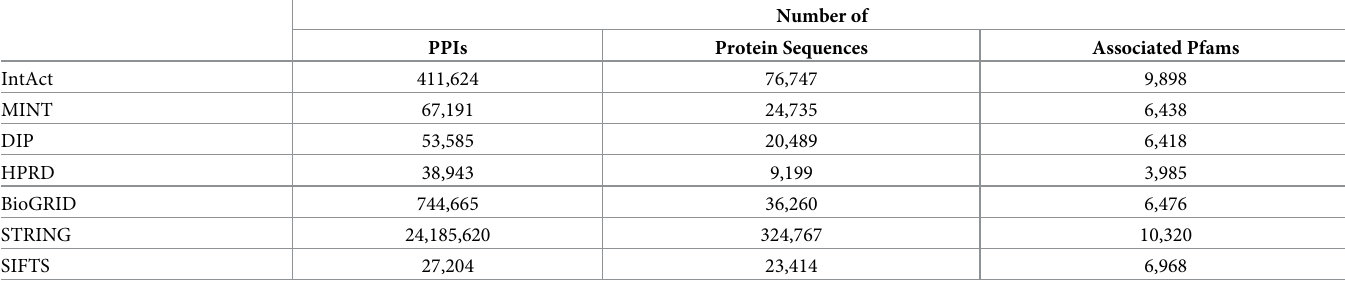
Table 1. Number of interactions, distinct sequences and Pfam domains obtained from the IntAct, MINT, DIP, HPRD, BioGRID, STRING, and SIFTS (all releases as of February